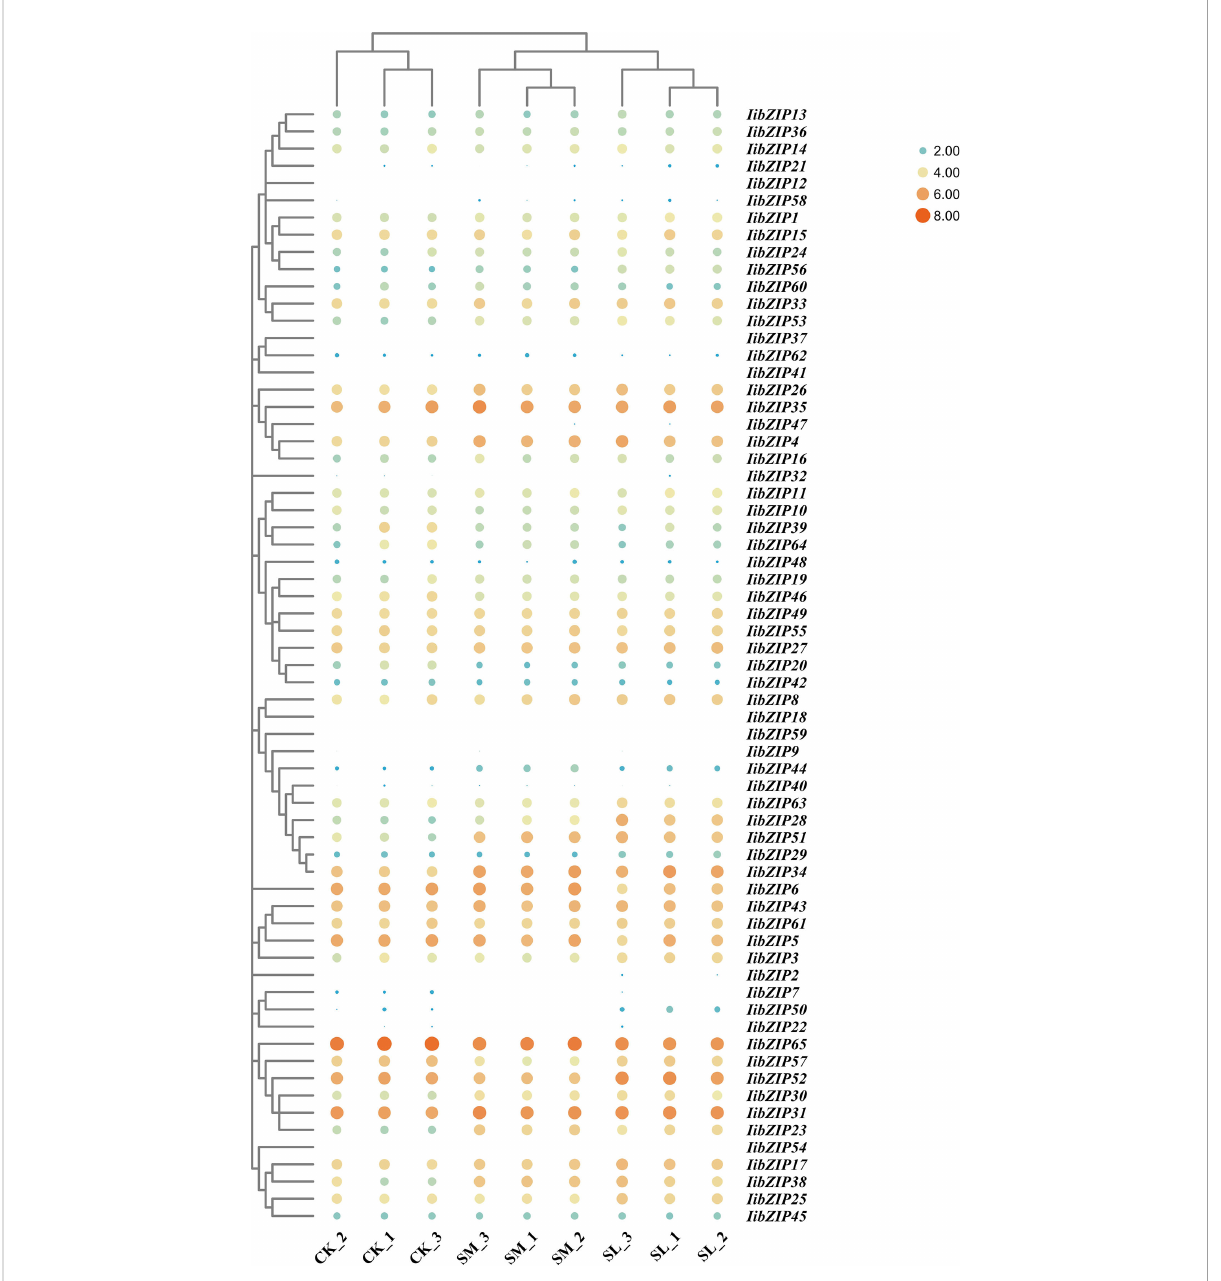
FIGURE 4 Heatmap of IibZIP gene expression in I. indigotica leaves under salt stress for different durations. The FPKM values were processed using row- scaling transformation. The dot size indicates the degree of gene expression. Different colors indicate the degree of gene expression: orange indicates higher expression and blue lower expression. CK, non-stress environment; SM, salt stress treatment for 24 h; SL, salt stress treatment for 48 h. Each group comprised three biological